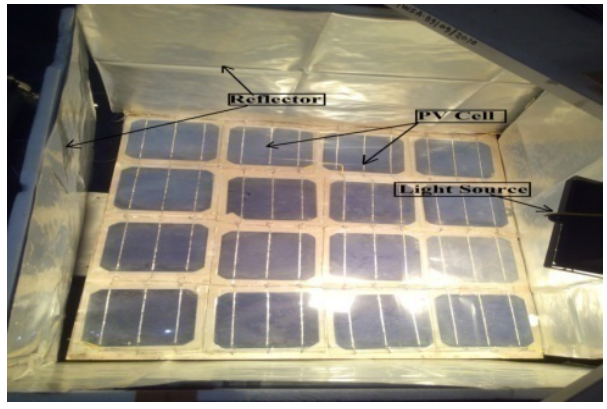
Figure 3. Experimental setup of clean PV module with reflector